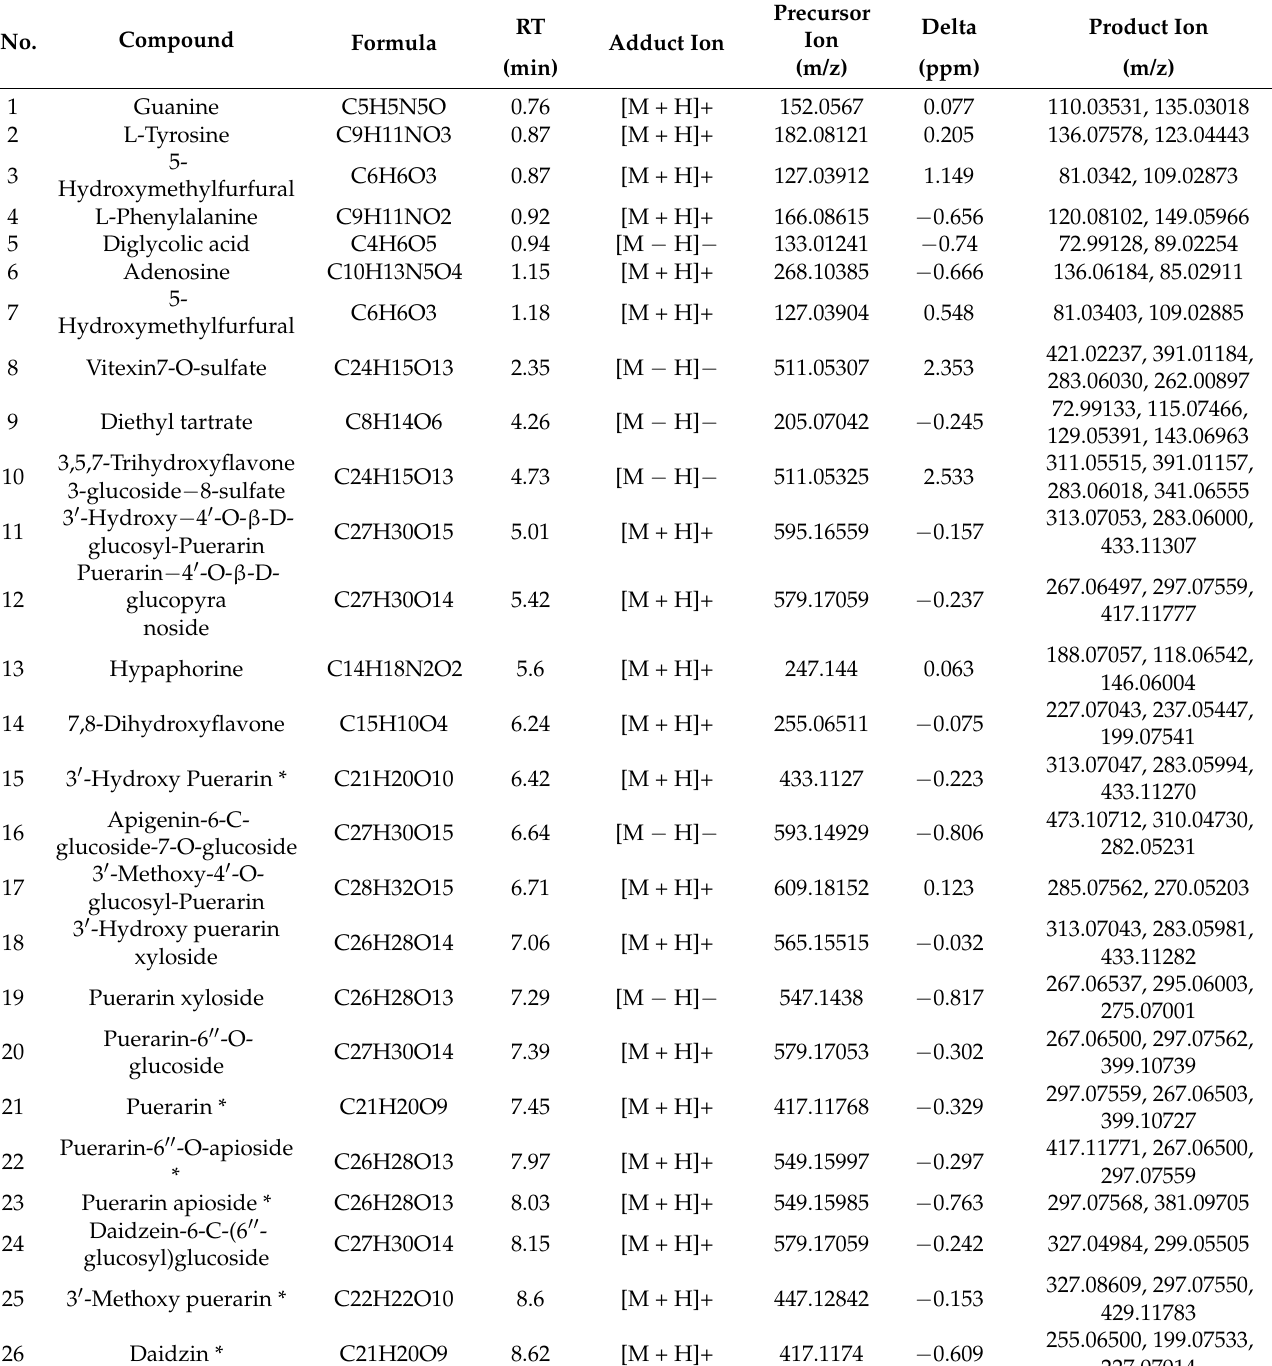
Table 4. Typical compounds identified from Pueraria by UHPLC-Q-Exactive